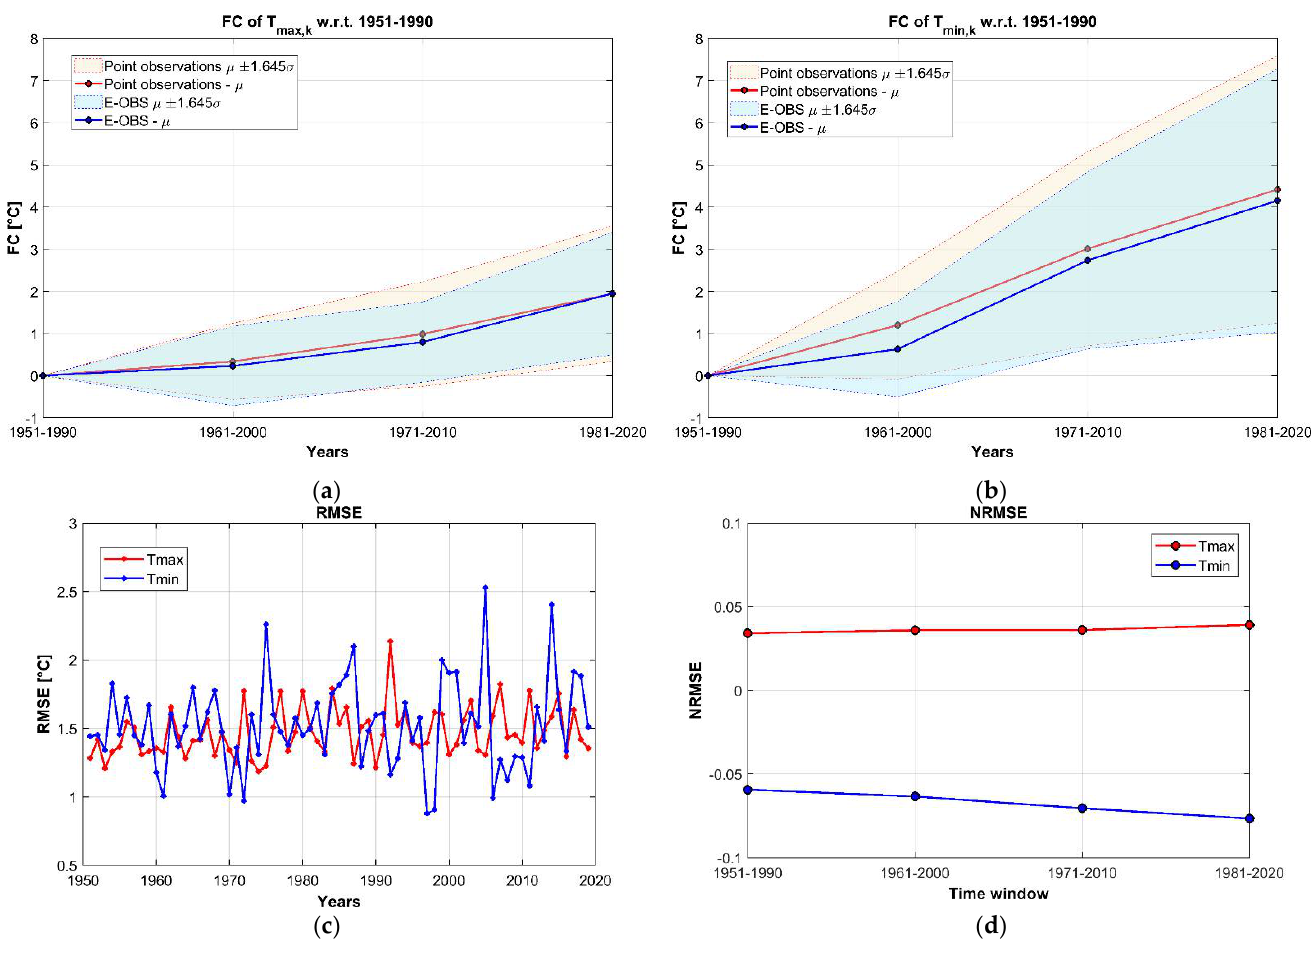
Figure 9. Factors of change for characteristic values of daily T max ( a ) and T min ( b ), root-mean-square error (RMSE) values for annual maxima of daily T max and annual minima of daily T min ( c ) and normalized root-mean-square error (NRMSE) values between characteristic values obtained by the gridded data and recorded values at the test stations ( d ).